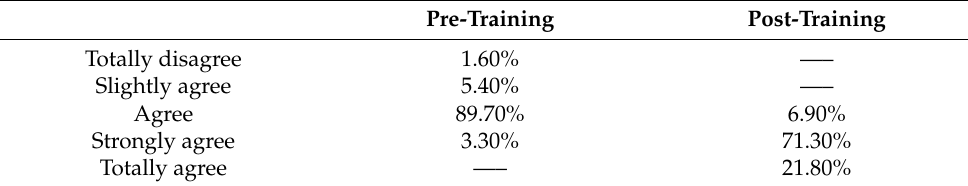
Table 4. Distribution of response percentages in item